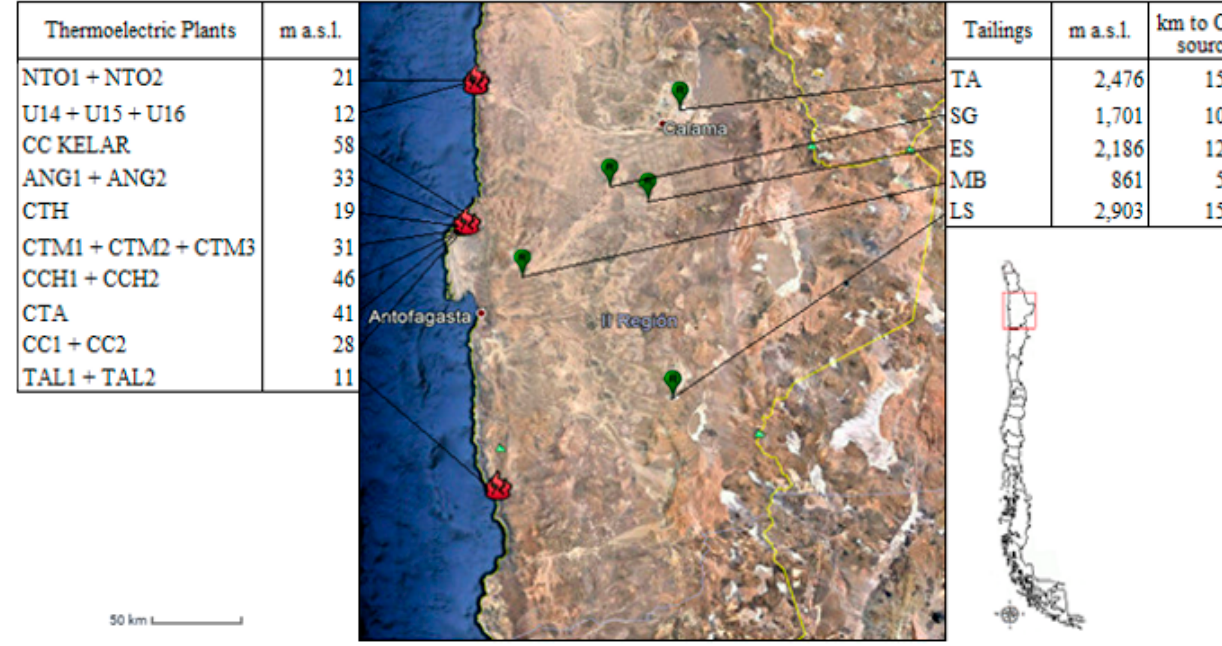
Figure 5. Location of thermoelectric plants and tailing deposits in the Antofagasta region. TA: Talabre tailing deposit; SG: Sierra Gorda tailing deposit; ES: Esperanza tailing deposit; MB: Mantos Blanco tailing deposit; LS: Laguna Seca tailing deposit; m.a.s.l: meters above sea level.